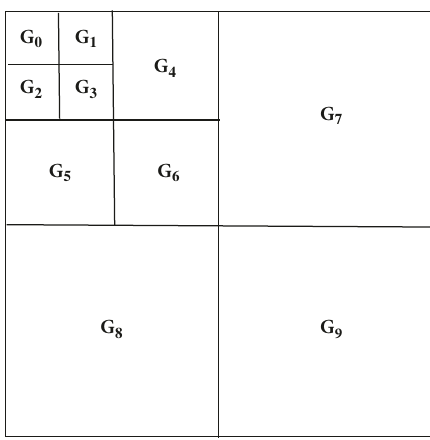
Figure 3: Reorganized coefficients of all 8 × 8 Krawtchouk moment blocks for the whole